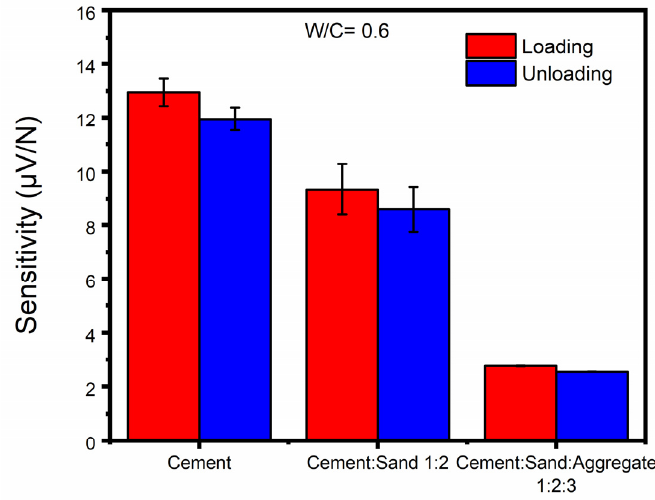
Figure 10. Average loading and unloading piezoelectric sensitivities of CNT-modified cementitious materials with the same W/C ratio of 0.6 but different concrete constituents.